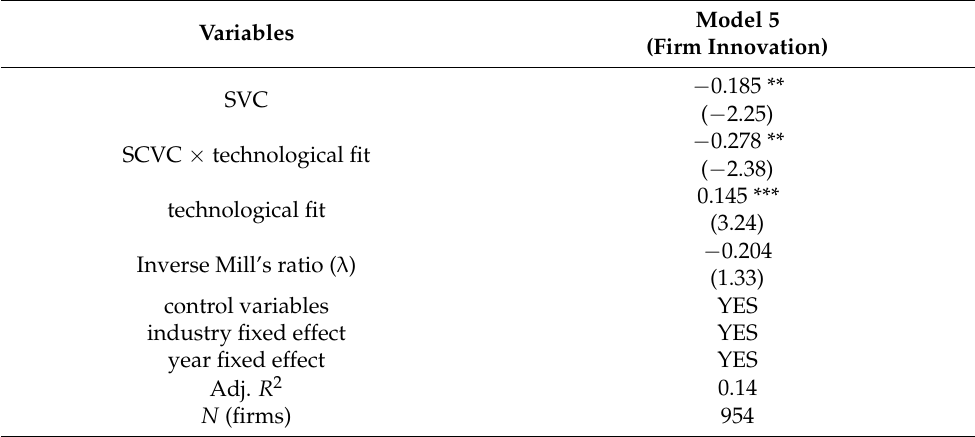
Table 6. Test of technical support hypothesis (second-stage OLS